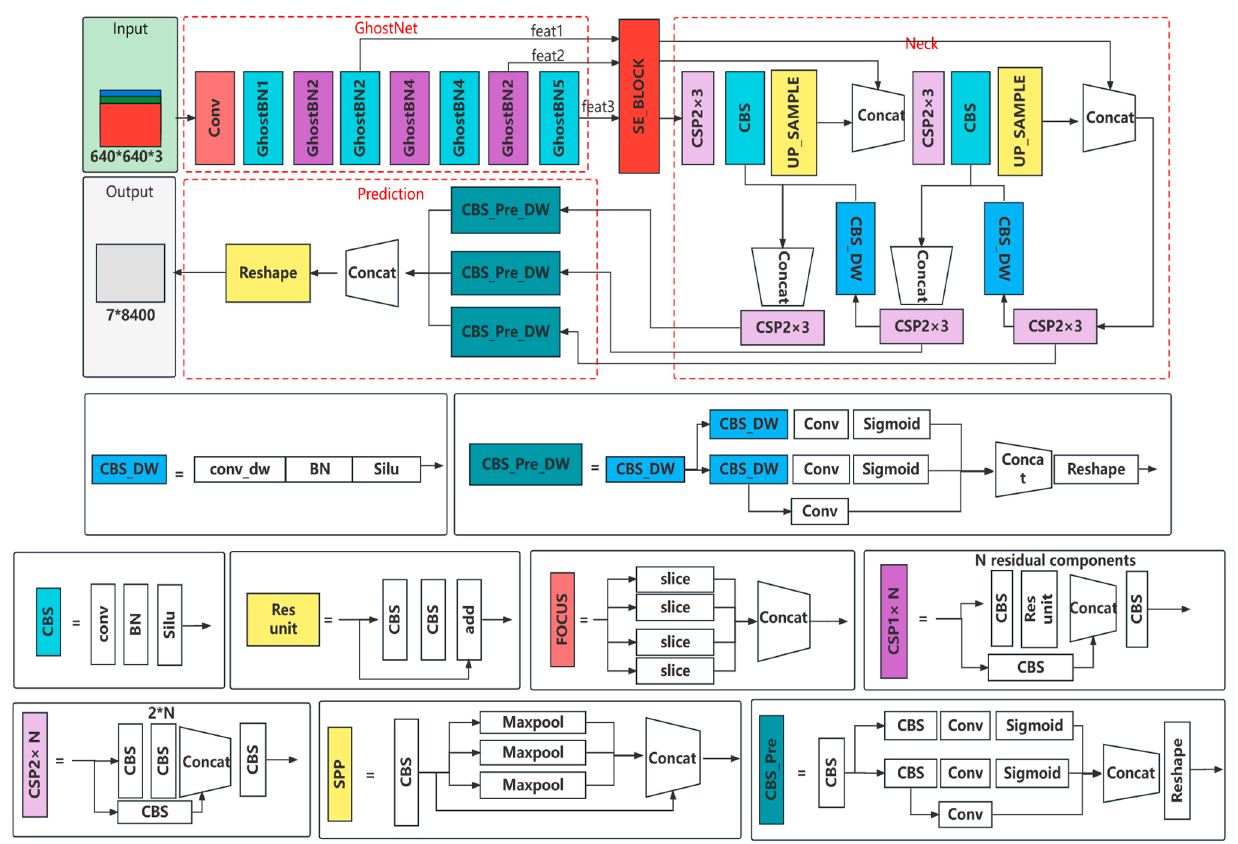
Figure 5. YOLOX-L-Light network